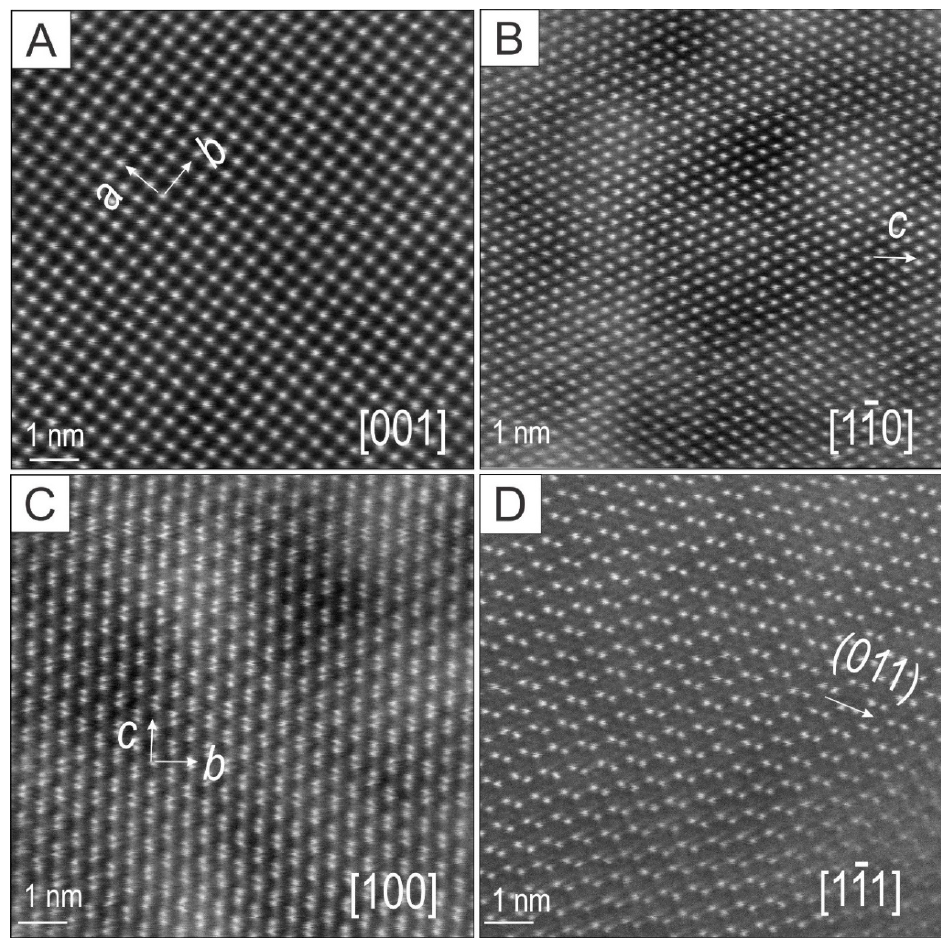
Figure 12. ( A – D ) High-resolution HAADF STEM images of zircon on four main zone axes as marked. Linear defects were observed along the edge of xenotime veinlets (e.g., Wirrda Well–Donington zircon; Figure 15B). Atom displacement across the two sides of the defect can be interpreted as resulting from a simple screw dislocation considering the “atom loop” observed on the defect plane. The “loop” is illustrated by the atoms placed between the two planes with different heights relative to one another across the defect (smaller size atoms highlighted in Figure 15B). Linear defects along kink faults were imaged on (001) zone axis in Charleston zircon (Figure 15C). In this case, the fault steps/widths changed irregularly, as shown by the presence or absence of “atom loops” on the defect plane (overlays on Figure 15C). Wider planar defects, tens of nm in width, also occurred in the Charleston zircon (Figure 15D). This image can also be interpreted as a simple screw dislocation (yellow lines in Figure 15D). Interstitial atoms were inferred within the defect area only. Their size and brightness changed relative to the Zr and Si atoms on the (001) zone axis in zircon outside the defect area. Such changes could reflect differences in atom heights between the two planes on either side of the defect, or more speculatively, could be attributed to the presence of foreign atoms occurring interstitially in the zircon lattice (mixed site Ti, Ca, Th, Y, etc.). The latter supposition can be correlated with the presence of mixed sites of Ti, Ca, Th, Y, etc., as is known from zirconolite (CaZrTi ₂ O ₇ ).